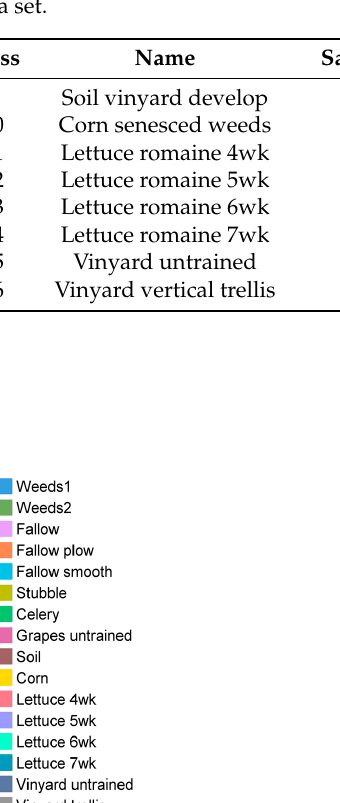
Figure 3. ( a ) False-color image and ( b ) ground truth map of the Pavia University data set.